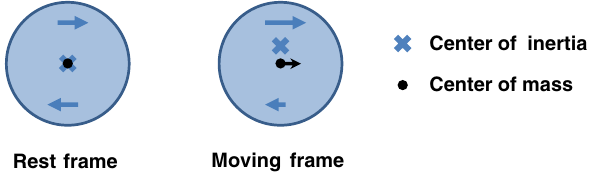
Fig. 1 For a spinning homogeneous sphere at rest, center of mass and center of inertia coincide with each other. When the sphere is moving in a direction orthogonal to its spin, the center of inertia moves away from the center of mass. The representation is purely schematic and does not take into account Lorentz contraction